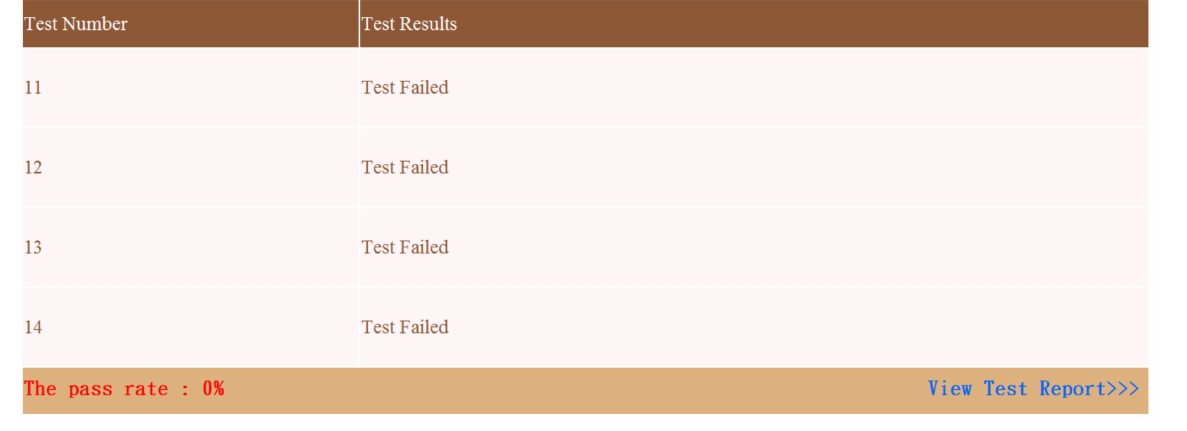
Figure 14. Test result (2).